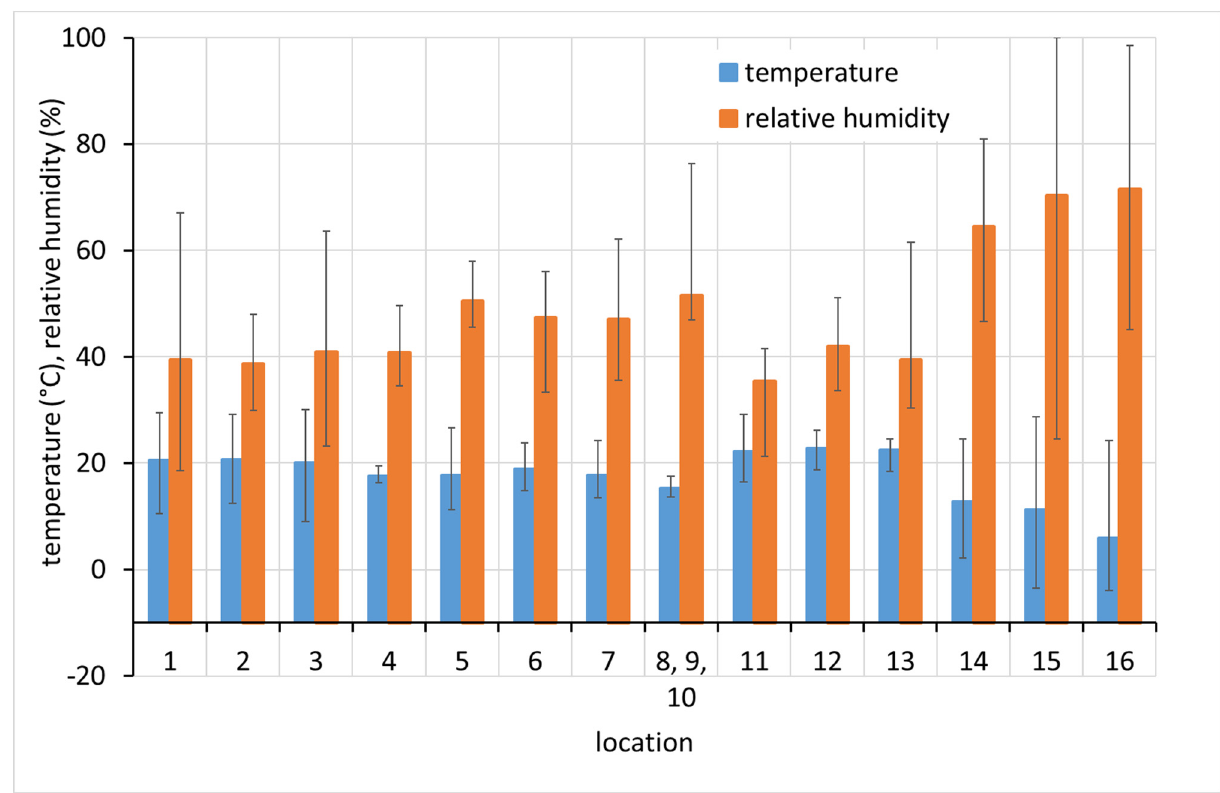
Figure 6. Overall average temperature and relative humidity values. Columns indicate average values and error bars indicate minimum and maximum values from complete dataset.